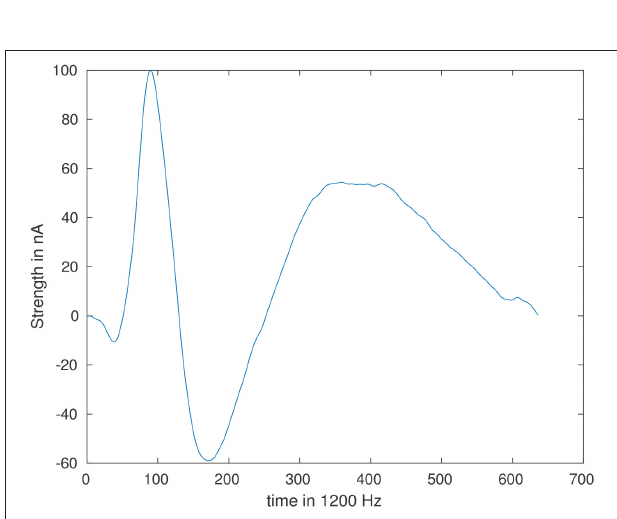
FIGURE 3 | Simulated waveform of interictal